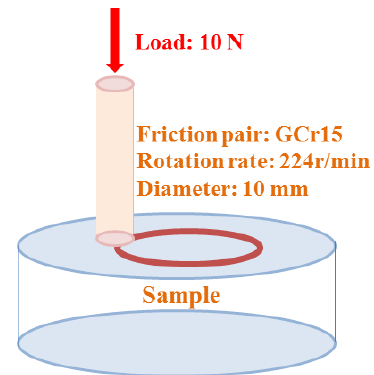
Figure 4. The diagram of the measuring station for abrasion .